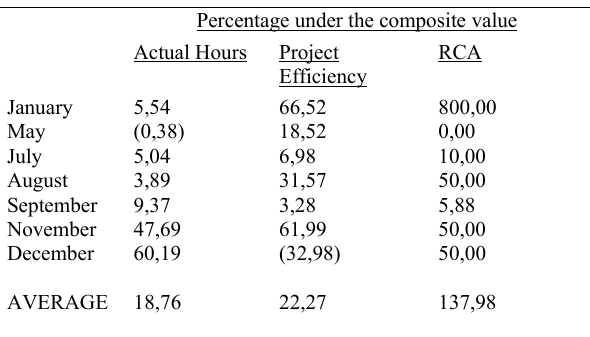
Table 6: Measure of efficiency of outputs produced for inefficient